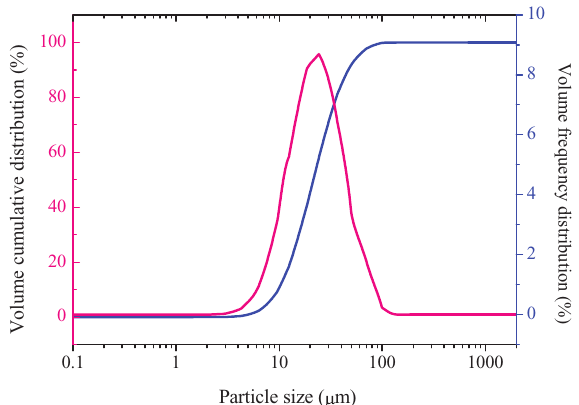
Figure 2: Grain size distribution curves of